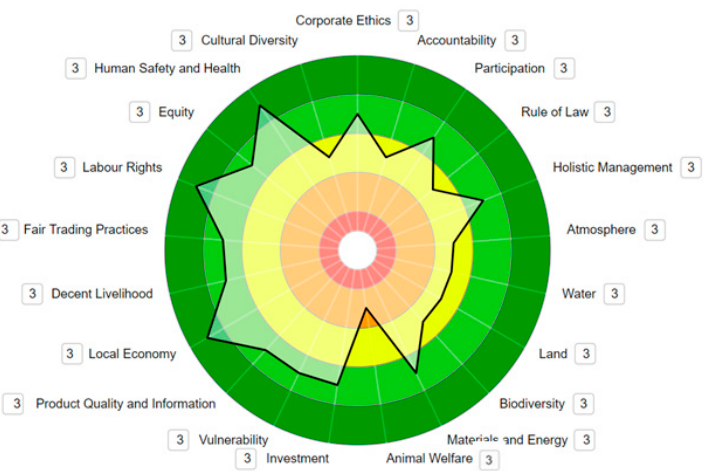
Figure 7. SAFA assessment result of the start-up as spider graph. The number near indicators suggest the data quality according to Table 4, and also, the colour in the circles represent the range score. As reported in Table 3, the colour means the performance score: Dark green: Best; light green: Good; yellow: Moderate; orange: Limited; red: Unacceptable. Yellow grades linked to soil indicators show the limited consideration of the topic, while green colour demonstrates the goodness of the management plan.